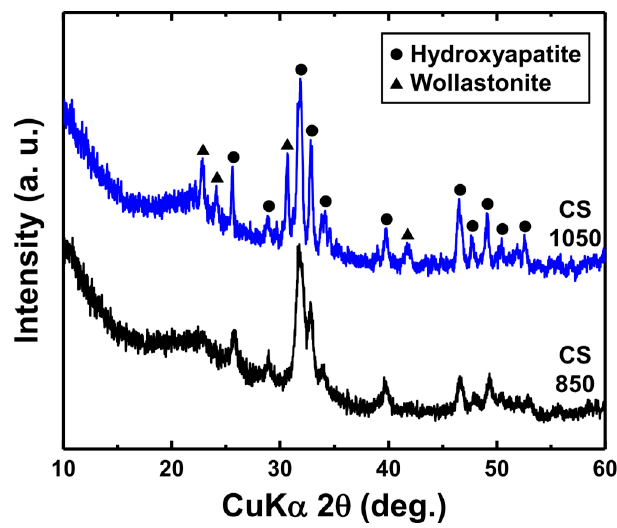
Figure 9. XRD patterns of CS850 and CS1050 sintered by the conventional process.